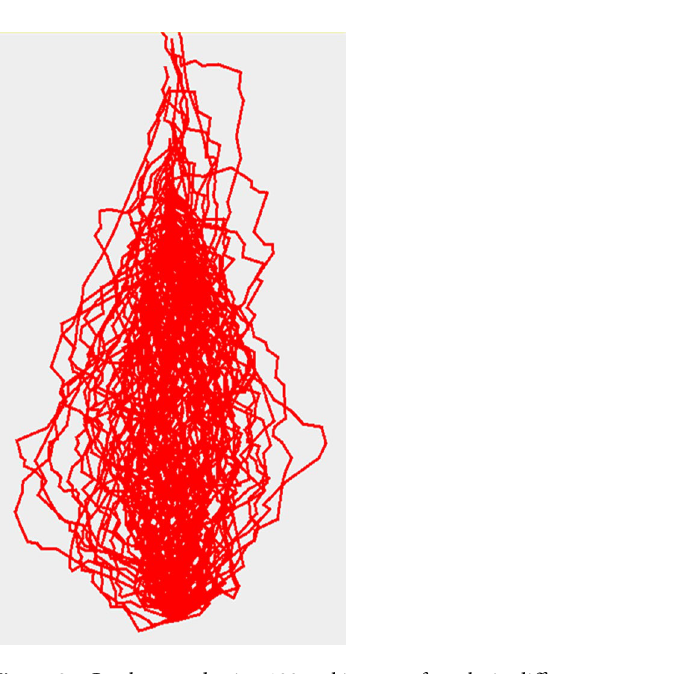
Figure 8. Cracks traced using 100 real images of cracks in different concrete pavement surfaces.